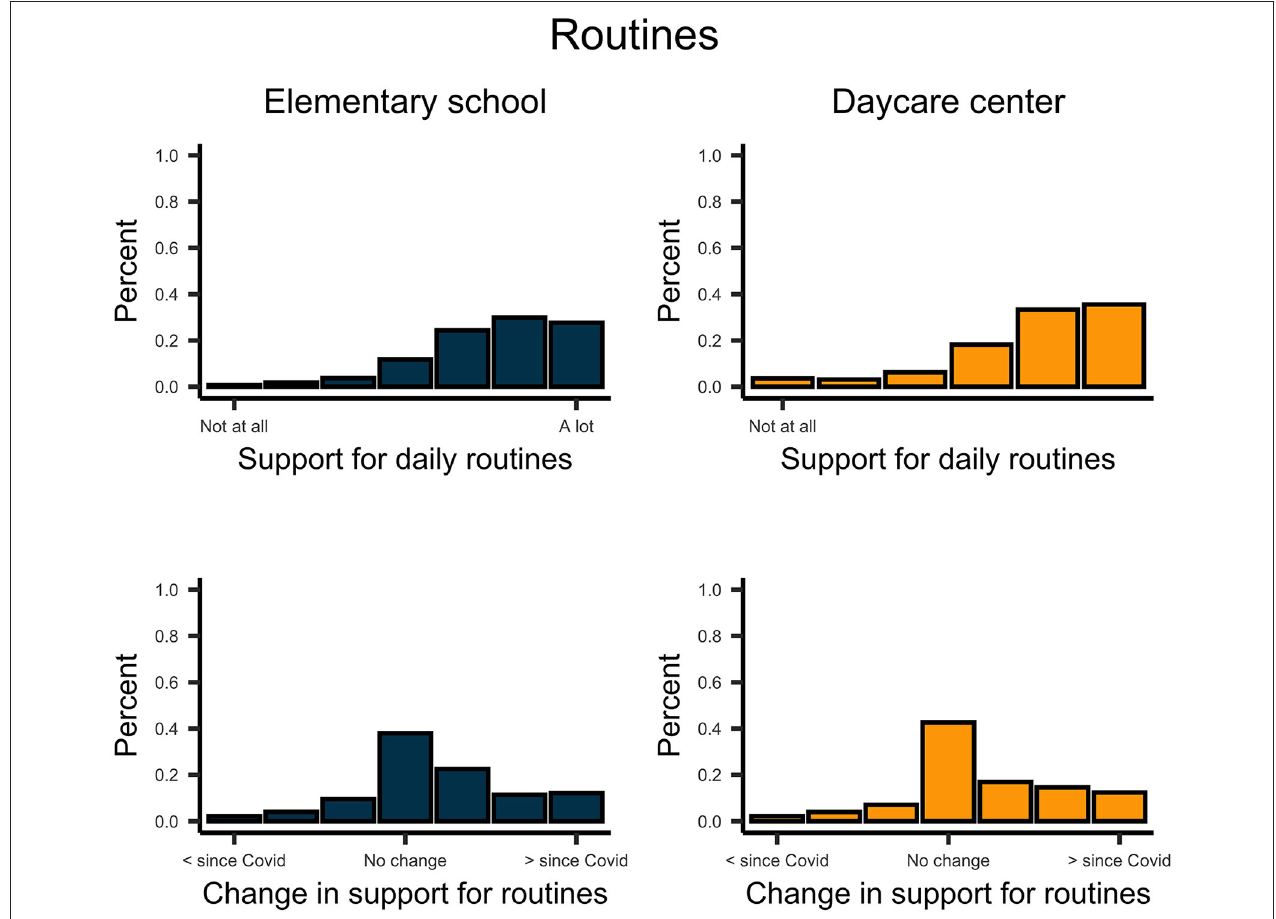
FIGURE 7 | Upper plots indicate the support of parents for the routines of school- and preschool-aged children. Lower plots indicate the change of this support since the COVID-19